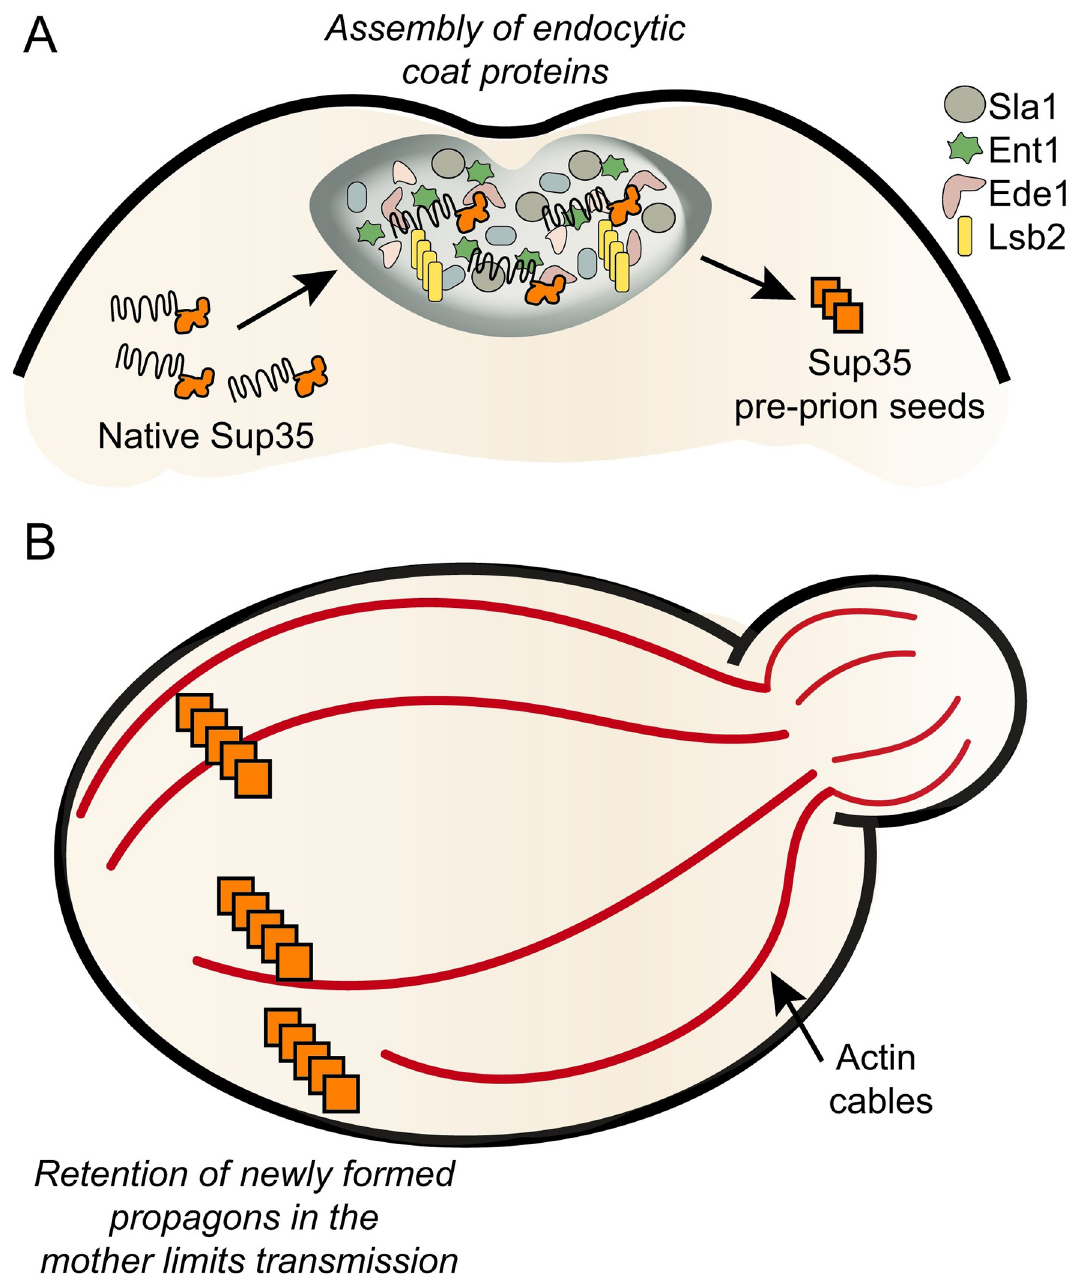
Fig 1. Model of actin in prion formation. (A) PrLD containing endocytic coat proteins (such as Sla1, Ede2, and Ent1, shown as shapes) are suggested to form condensates that mediate the initiation of endocytosis. In addition, the Lsb2 endocytic coat protein forms metastable prions (shown in yellow), although it is unclear whether these metastable prions are associated with the endocytic condensate. The presence of condensates or metastable prions may recruit the prion domain of Sup35 (orange protein with prion domain shown as black line) to nucleate the formation of pre-prion seeds. (B) Actin cable networks (red) have been shown to play a role in the retention of unhealthy organelles or damaged proteins in the mother cell. Recent work has shown that the disruption of actin cables is associated with increased [ PSI + ] induction frequencies, which may facilitate enhanced transmission of propagons. Therefore, the implications of this study suggest that normal actin cables may play an important role in restricting propagon transmission to daughter